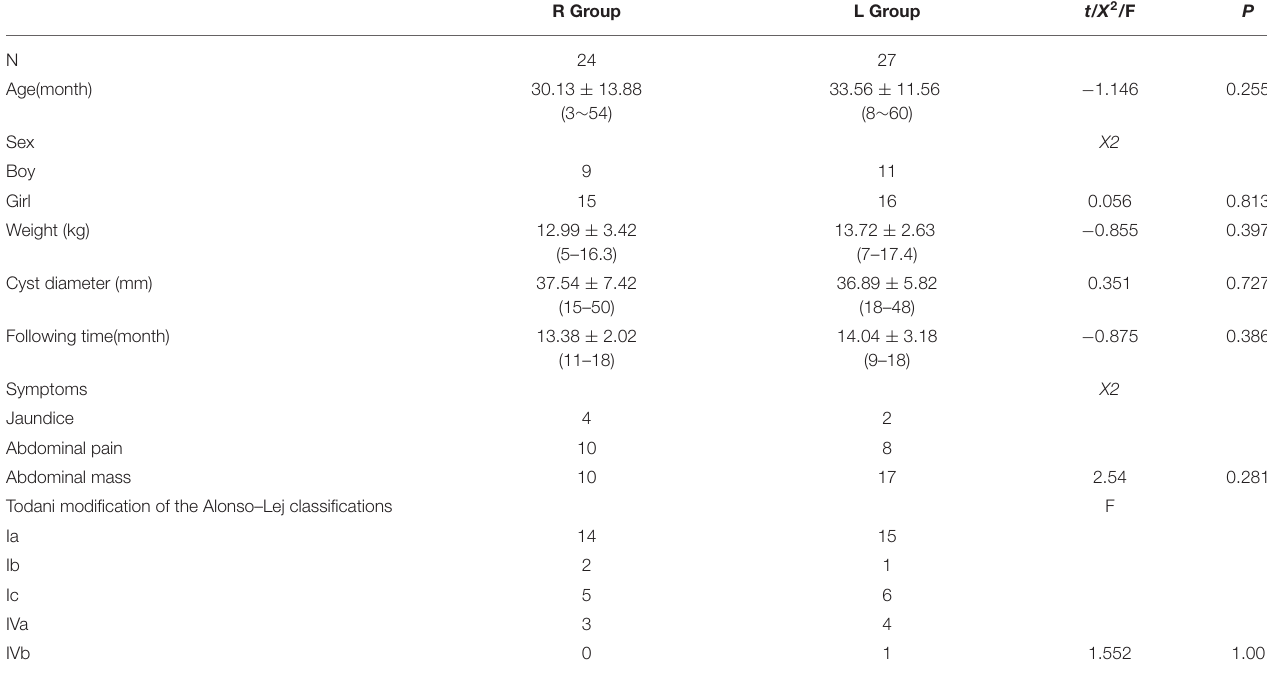
TABLE 1 | Demographic